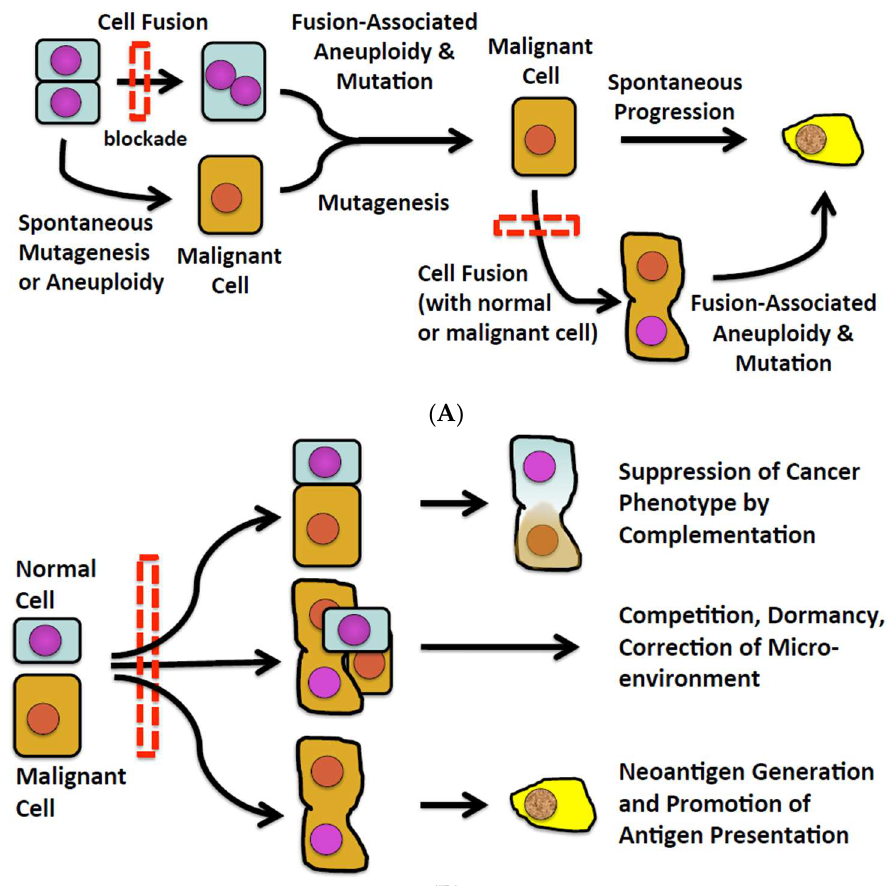
Figure 1. ( A ) The conventional view of cell fusion in malignancy. ( B ) A new perspective of cell fusion as a defense against malignancy.